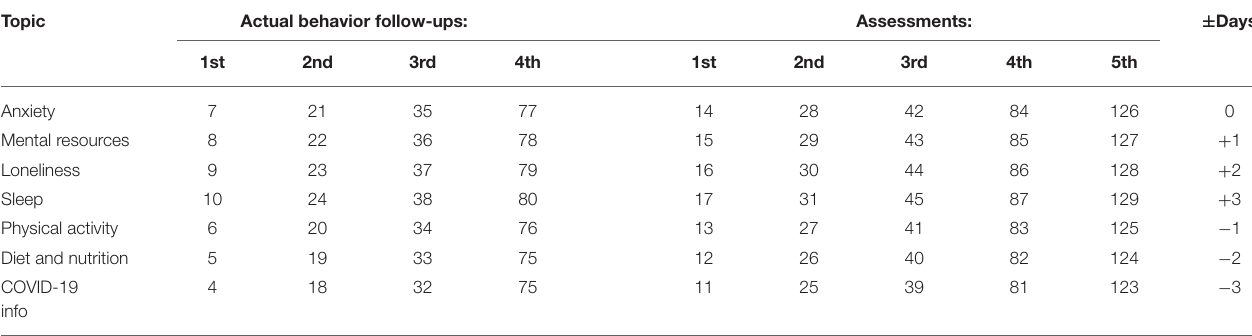
TABLE 4 | Timing schedule of assessment and actual behavior questions in days.